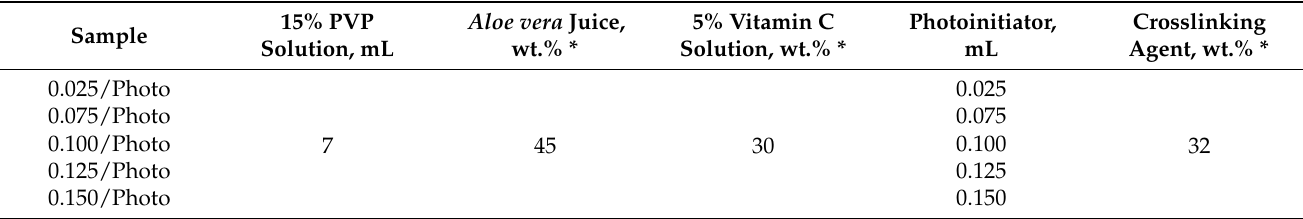
Table 1. Compositions of